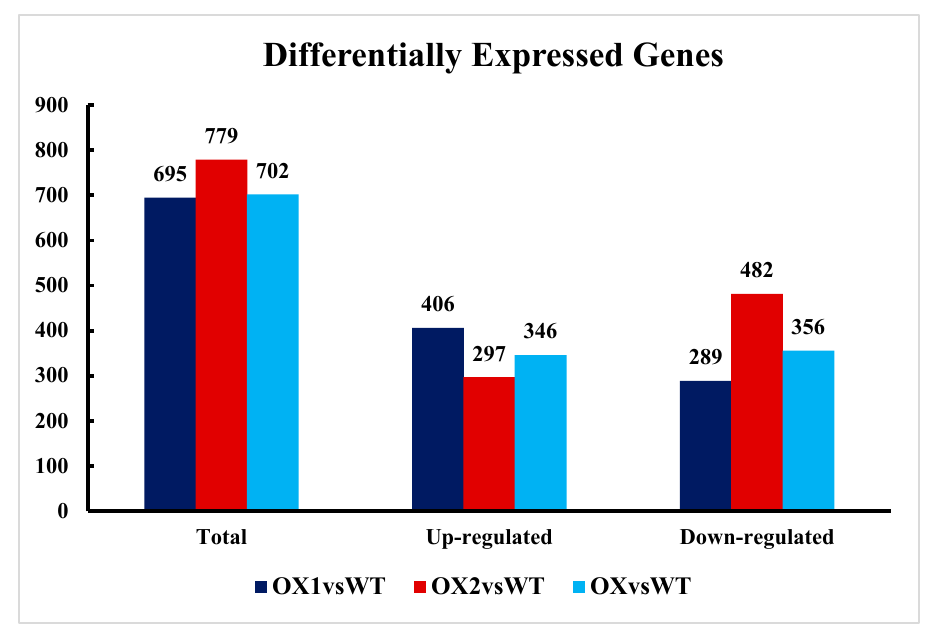
Figure 6. DEGs (differentially expressed genes) in OX1 vs. WT, OX2 vs. WT, and OX vs. WT groups in A. thaliana . The means of RNA-seq. analysis data are the ± SD ( n = 3) and means showing effective difference ( p < 0.05).